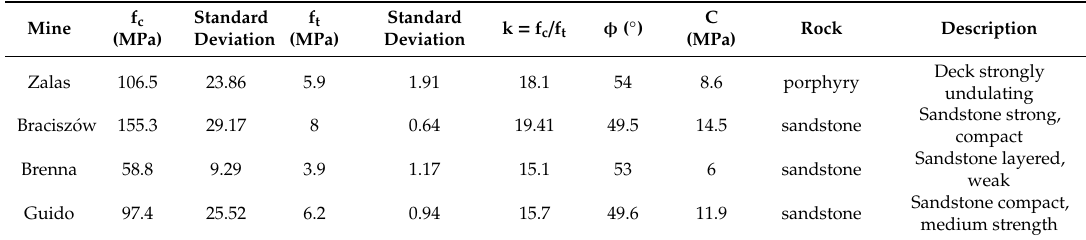
Table 3. Mechanical parameters of the studied rocks.